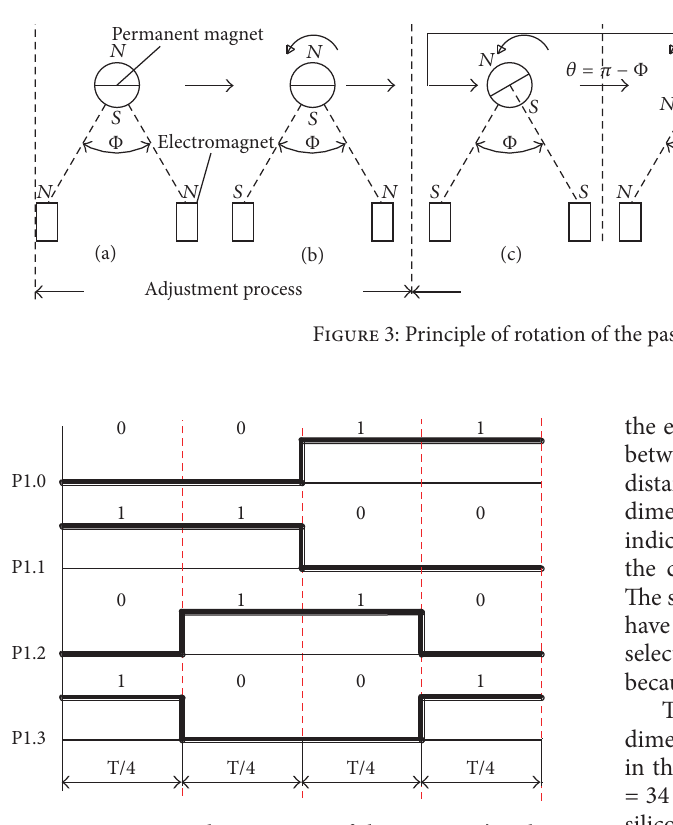
Figure 4: Output pulse succession of electromagnet’s coil.